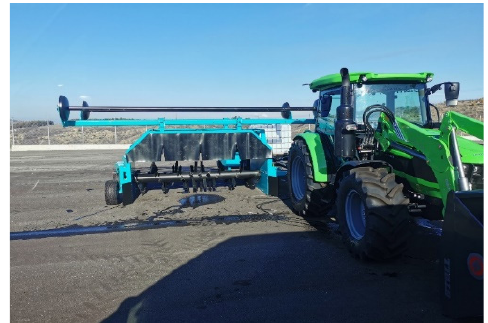
Figure 5. Compost turner (AFN 3000, KRAUSE).